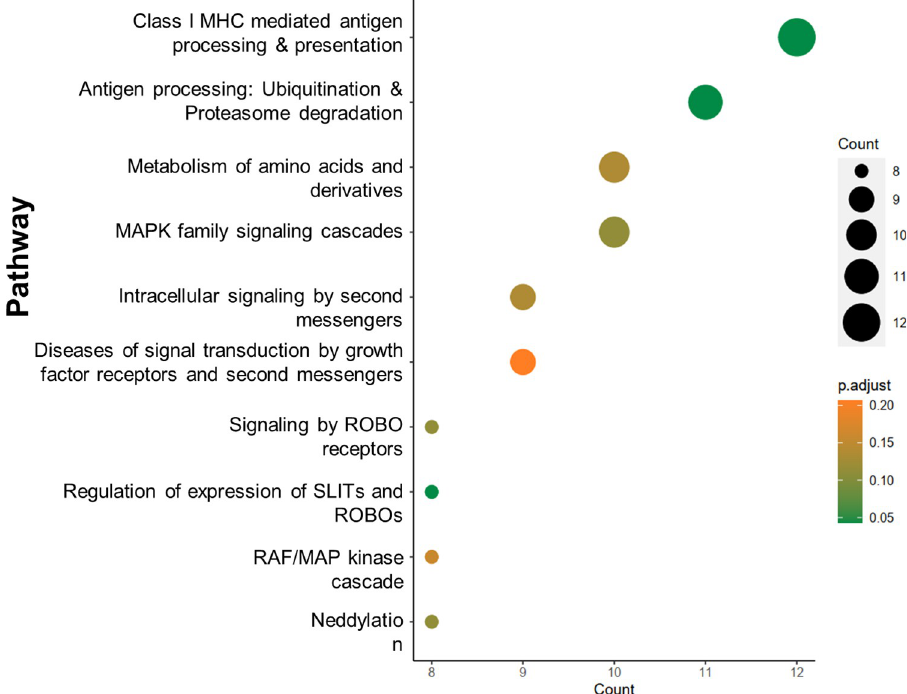
Fig 3. Pathway analysis. Reactome Pathway Analysis was performed using the top 1% list of genes according to MaGeCK rank. Class I MHC mediated antigen processing & presentation pathway was the most enriched pathway with 12 genes and p-adjust value < 0.05. Genes associated to this pathway by Reactome Pathway Analysis were B2M, UBE4A, CUL3, KLHL22, PSME1, UBE2F, RNF41, PSMC3, TRIM4, PSMA8, TRIP12, ASB17.